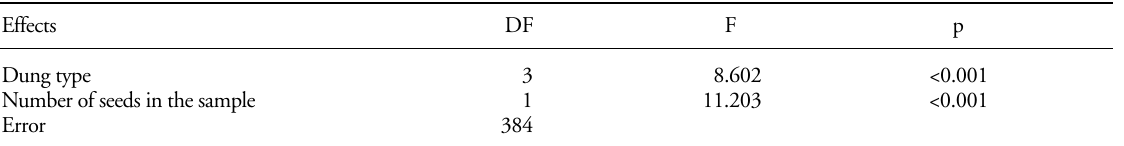
Table 2. Summary of ANCOVA results for the relationship of the accuracy of the seed density estimation of dung samples obtained after one-year cultivation with the factor dung type and the covariate number of seeds in the sample.